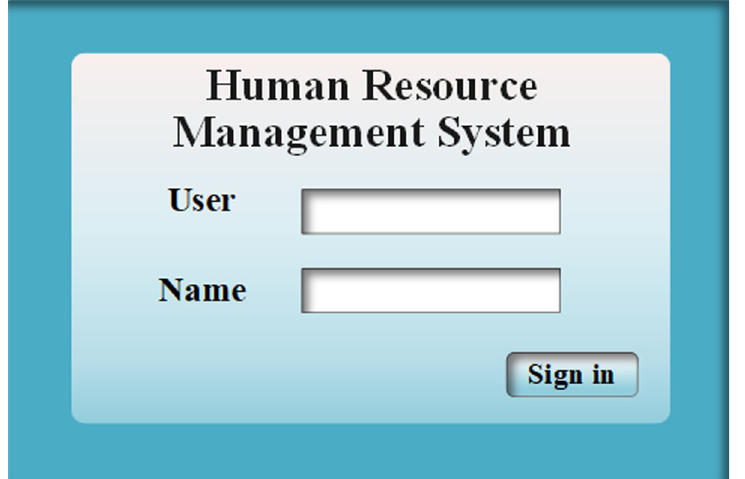
Fig 11. Realization effect of login page of the system.